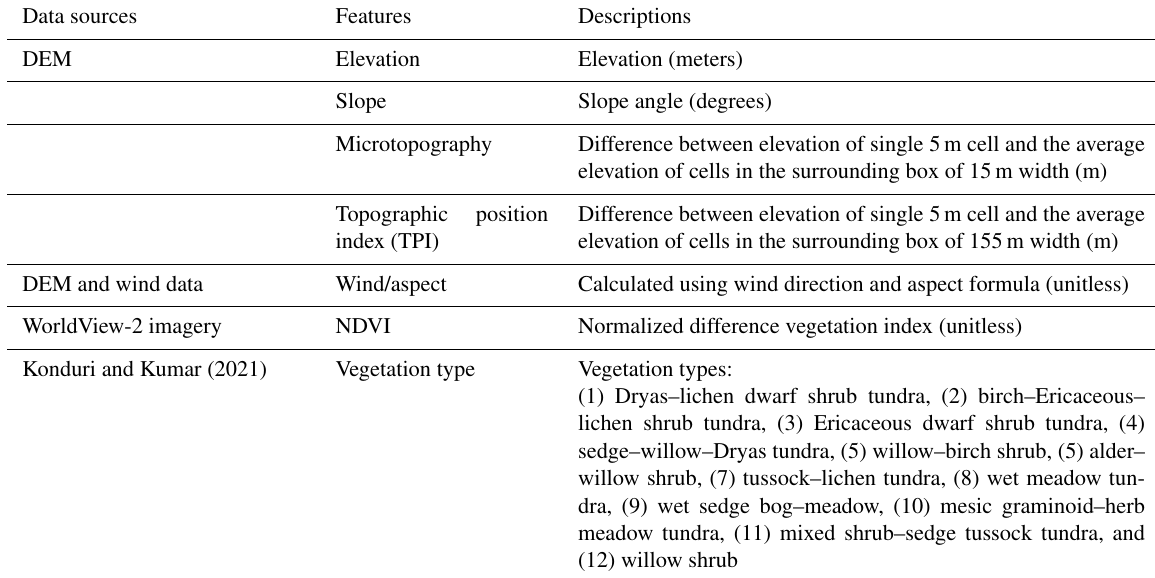
Table 1. Topography and vegetation data sources. Data sources for the input features are listed on the left, and the description of the features are listed on the right. Note: DEM stands for digital elevation